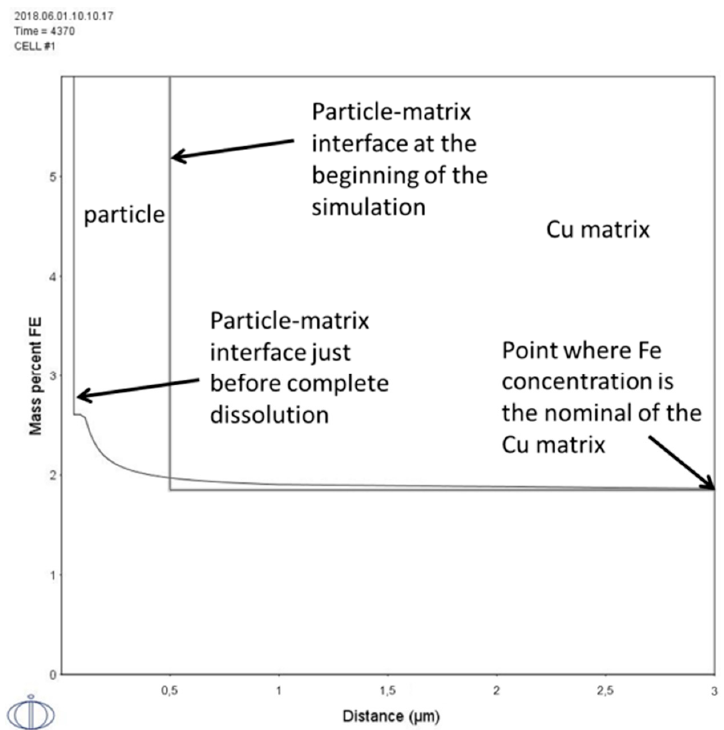
Figure 8. Fe concentration around a 1 µ m ( R = 0.5 µ m) particle at the beginning and the end of the dissolution process.